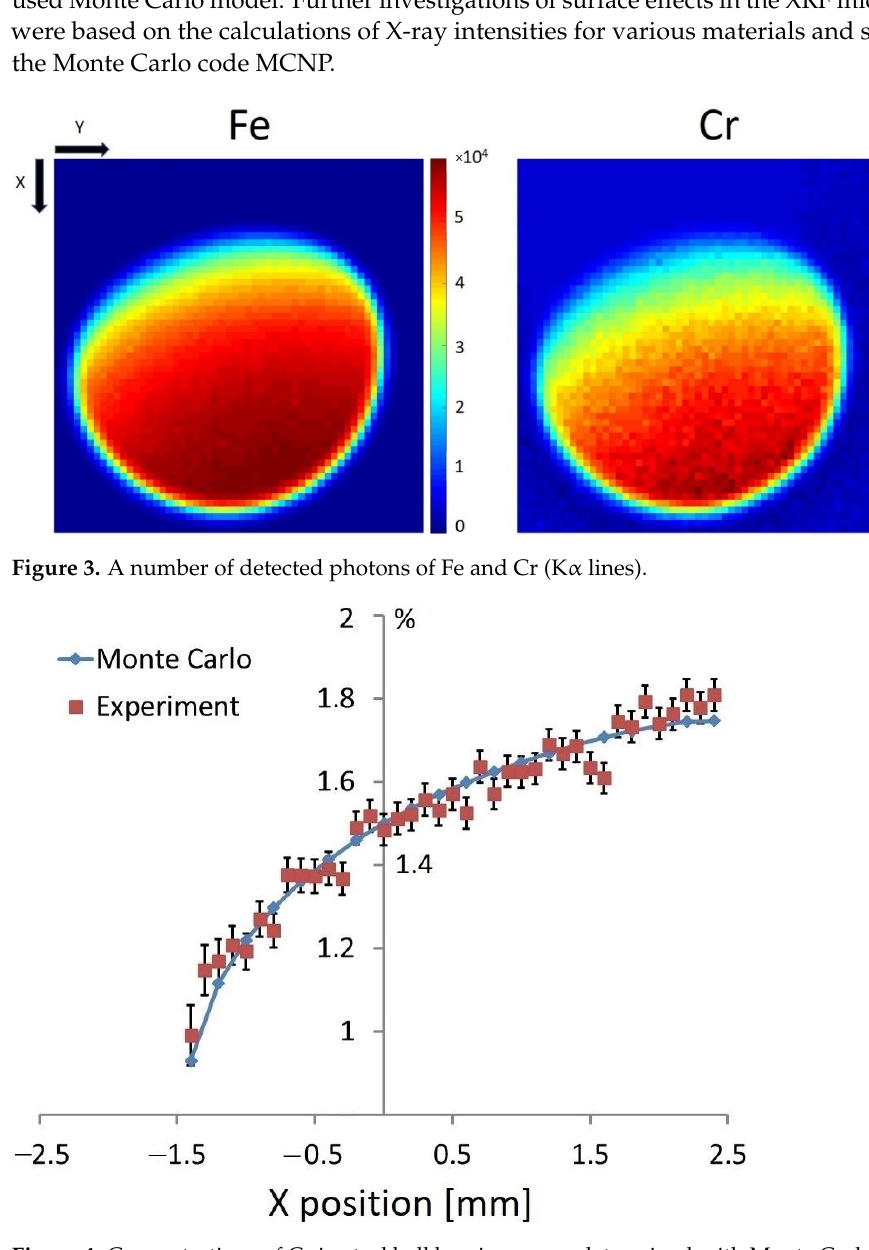
Figure 4. Concentrations of Cr in steel ball bearings were determined with Monte Carlo